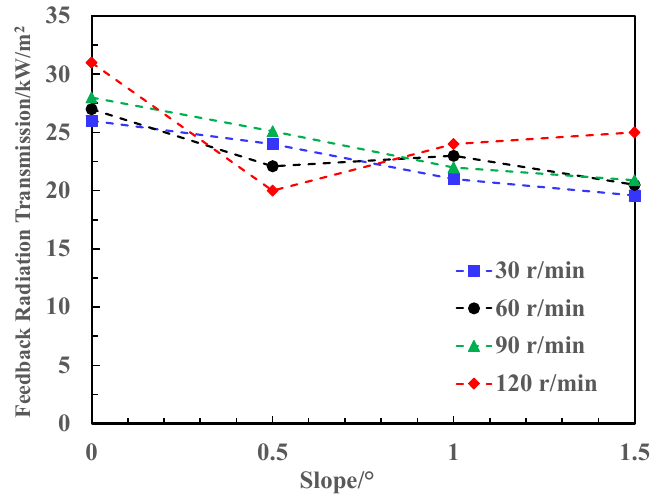
Figure 8. Variation of n-heptane flame feedback radiation transmission with slope. Zhao et al. [8] proposed that the feedback radiation transmission of an n-heptane thin oil pool fire can be expressed by the following equation, based on the experimental study on the burning process of a thin oil pool fire: